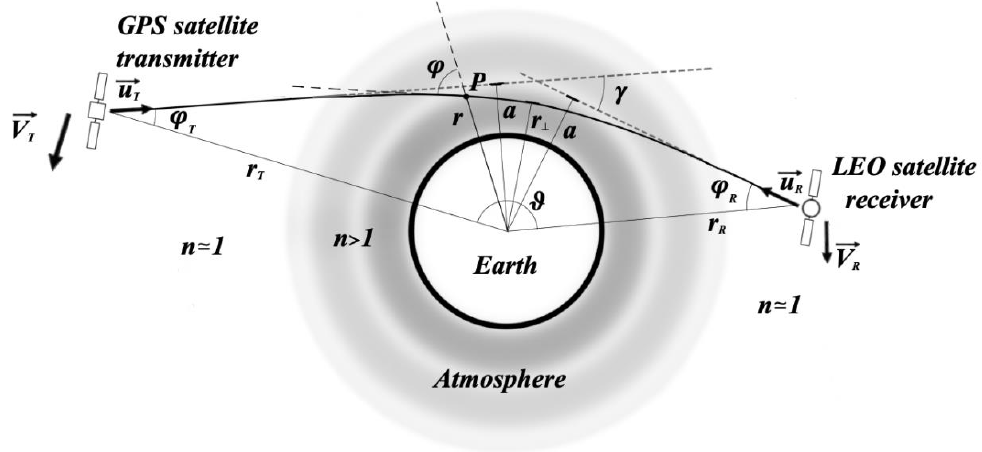
Figure 1. Graphical representation of an RO observation. The main RO parameters are also reported. Radio signals from the GPS transmitter deviate from the straight line by a bending angle 𝛾 towards the LEO receiver, due to the refraction of the atmosphere. Impact parameter of the incoming signal is denoted by 𝑎 , while 𝜑 is the incident angle of the ray line on the spherical surface of constant refraction index 𝑛 . Bending angles 𝛾 and impact parameters 𝑎 are estimated by Doppler shift measurements of the carrier frequency, if the satellites ’ positions and velocities, respectively 𝑟⃗ 𝑇 , 𝑟⃗ 𝑅 and 𝑉⃗⃗ 𝑇 , 𝑉⃗⃗ 𝑅 are known. More information about the mentioned parameters can be found in [15].